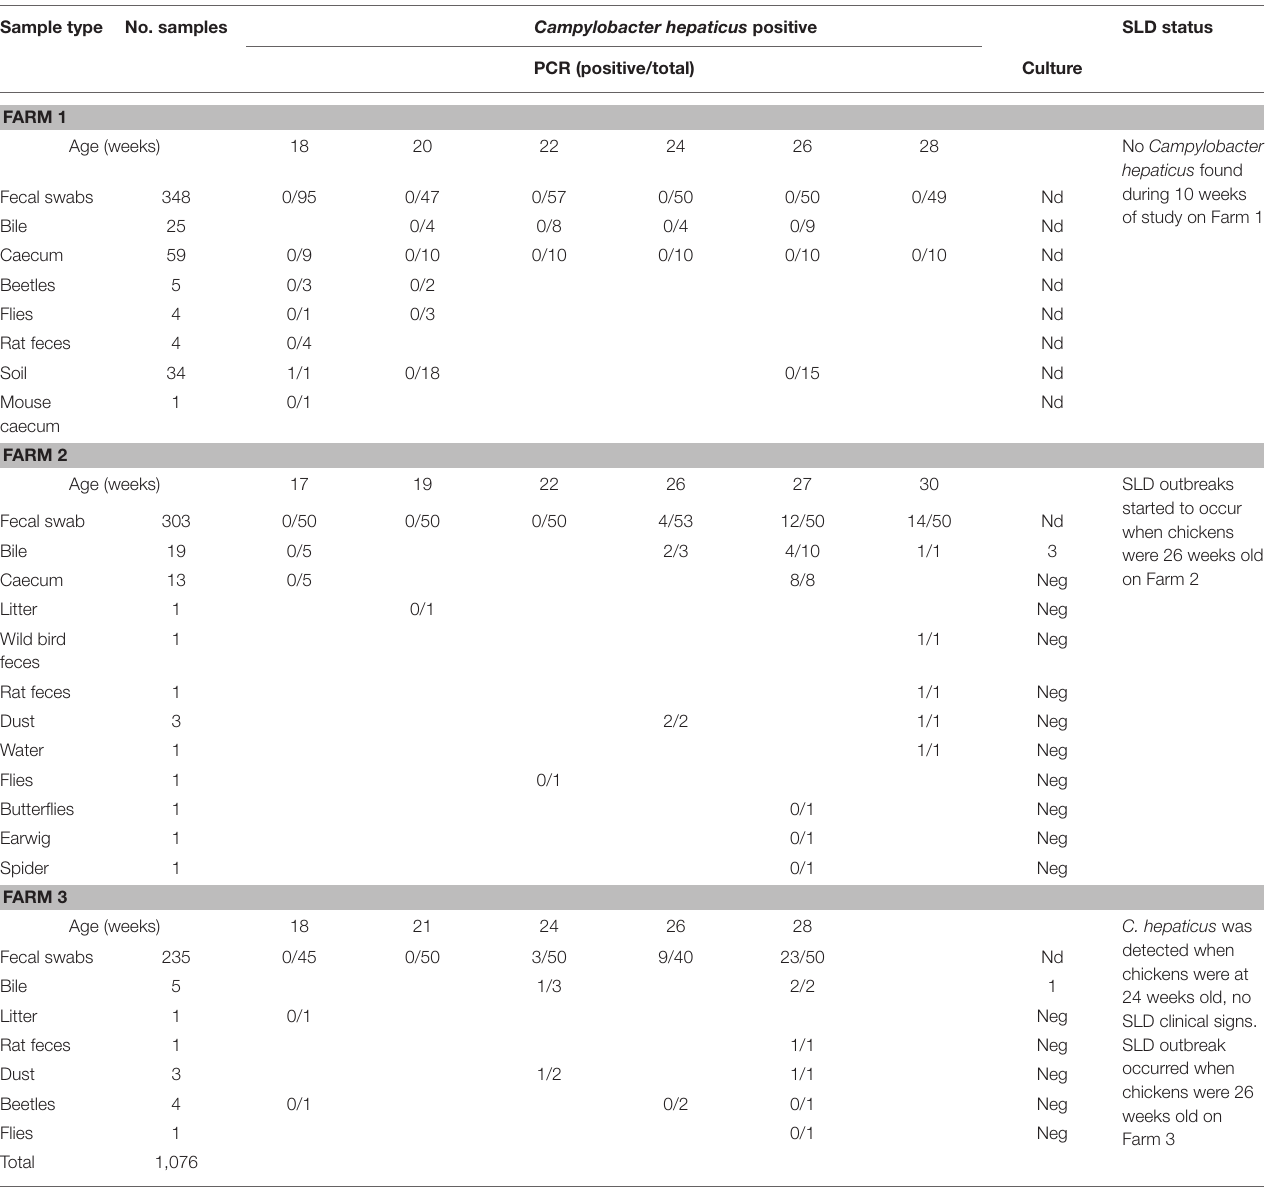
TABLE 1 | The presence of Campylobacter hepaticus in three farms monitored over time. Sample type No.